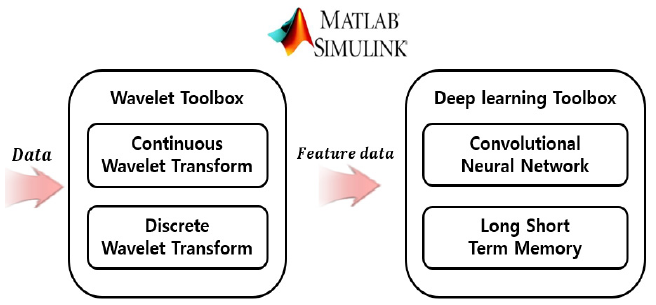
Figure 8. Schematic diagram of the simulation system.